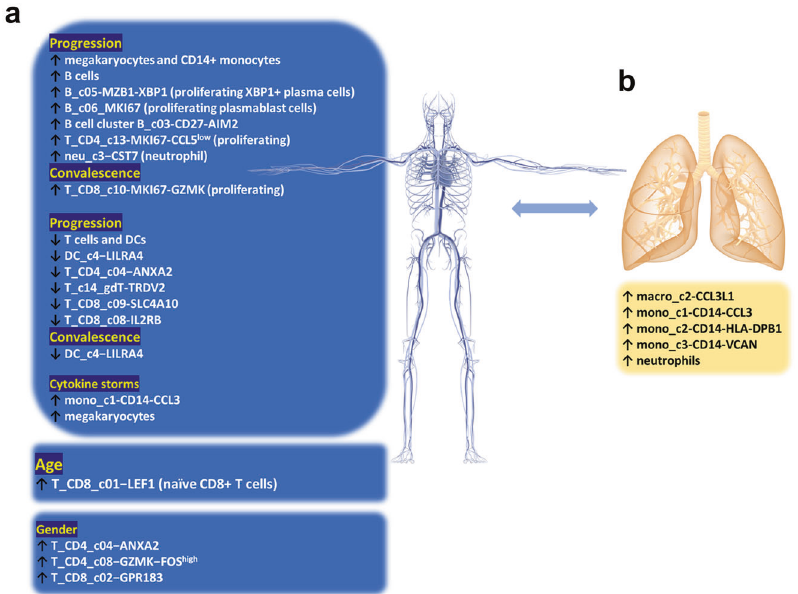
Fig. 1 Schematic presentation of altered immune subsets in the periphery and lungs from COVID-19 patients. Frequencies of immune subsets in the circulation ( a ) and lung tissue ( b ) from patients with COVID-19. ↑ indicates increased while ↓ indicates decreased